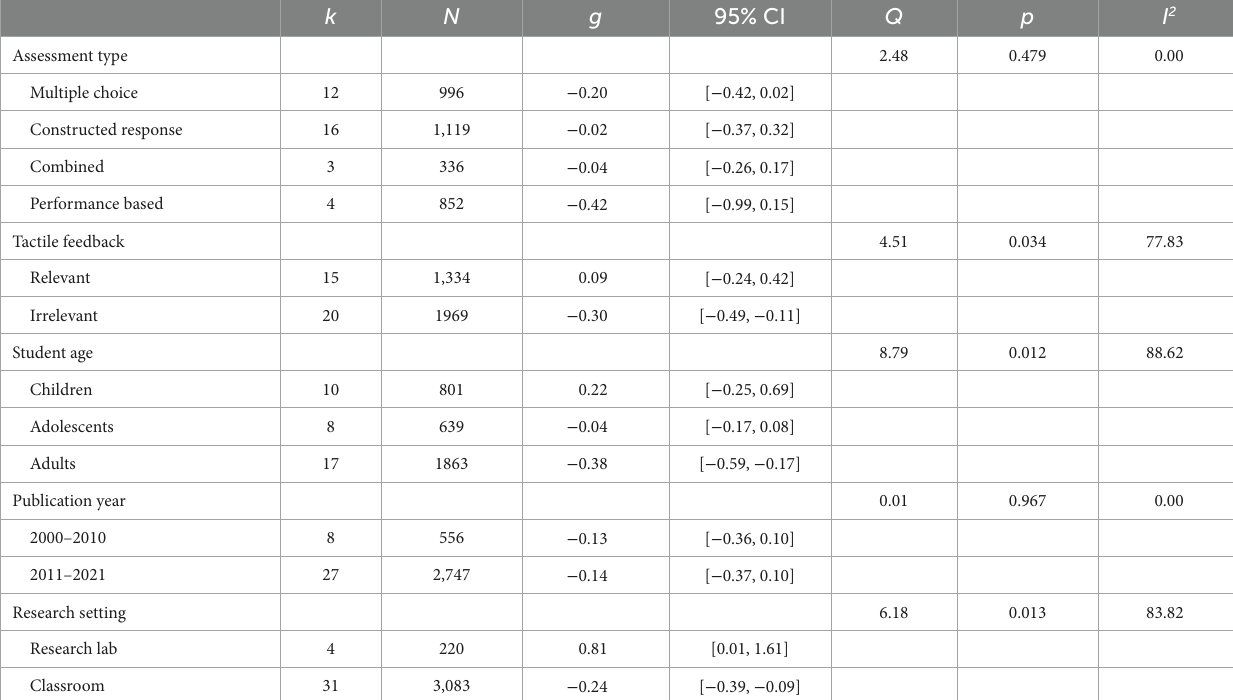
TABLE 1 Results of the moderator